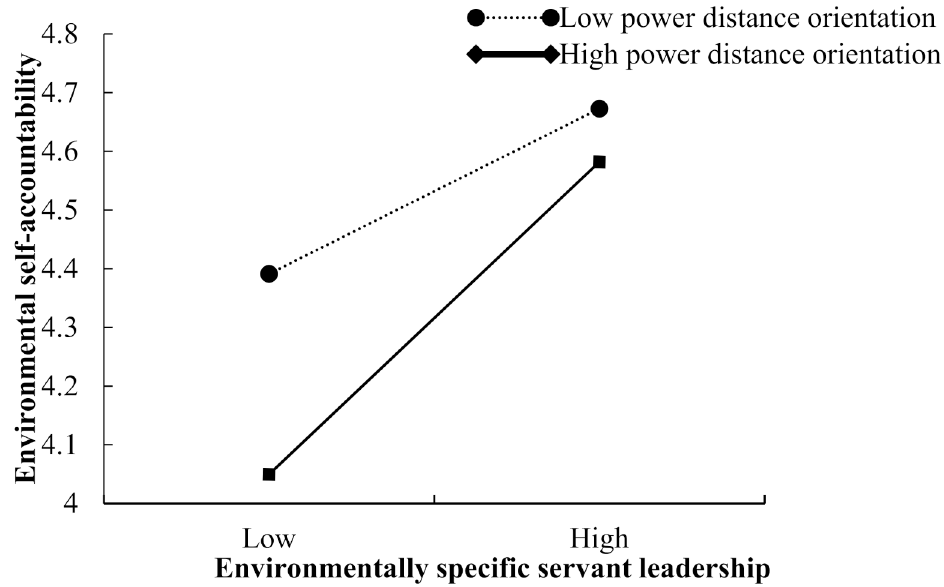
Figure 2. The moderating effect of power distance orientation on the relationship between environ- mentally specific servant leadership and environmental self-accountability.